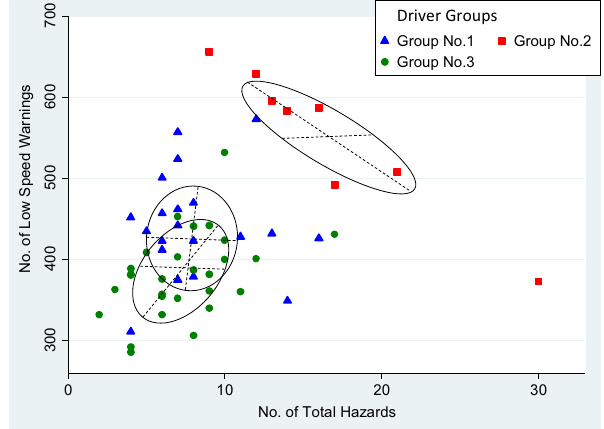
Fig. 2 Driver-classification graph of No. of Low-speed Warnings against No. of Total Hazards for model EEV with 3 groups/clusters having BIC of −